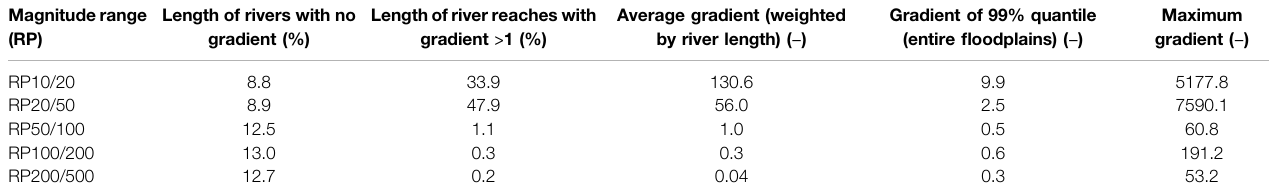
TABLE 1 | Mean and maximum values of normalized gradients of river reaches where the basic event has a fl ood exposure greater than 0. Magnituderange Length of rivers with no Lengthofriverreaches with Average gradient (weighted (RP) gradient (%) gradient > 1 (%) by river length) ( − )